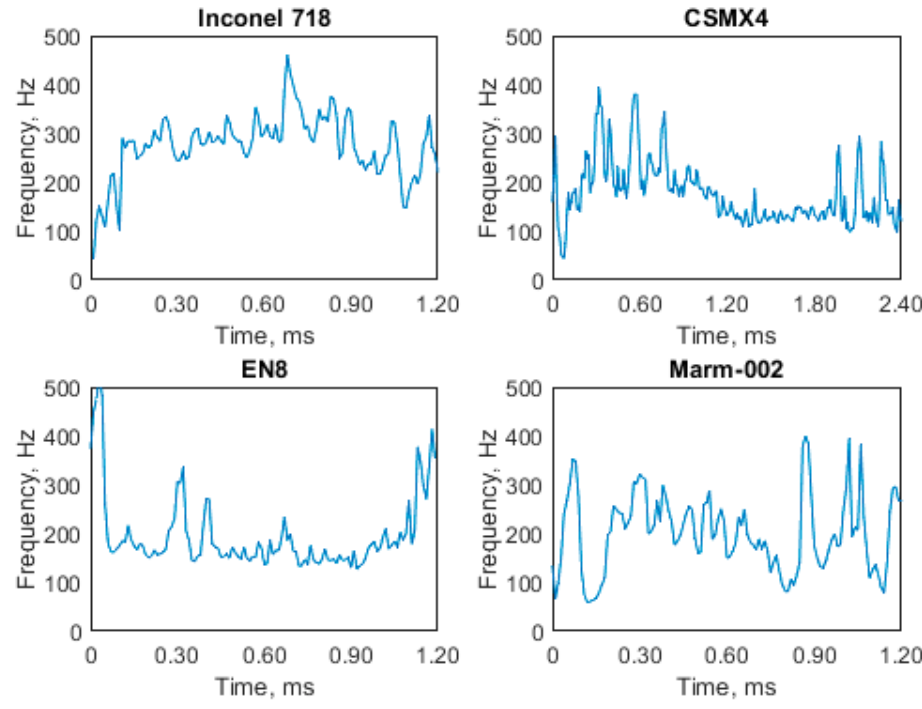
Figure 22. Centroid Frequency of the SG tests for Inconel 718, CSMX4, EN8, and MARM-002.